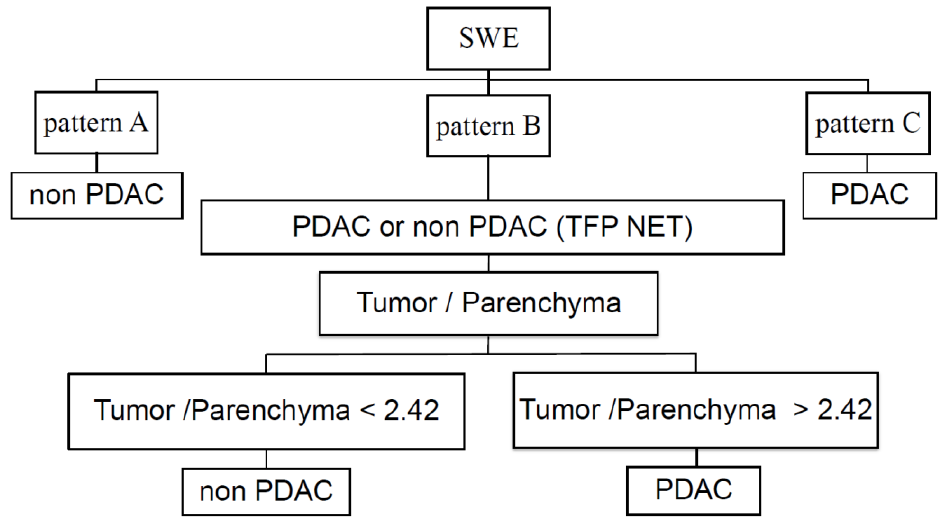
Figure 4. Diagnostic algorithm of pancreatic lesion was proposed by using SWE mapping patterns and SWE value ratio between tumor and non-tumor